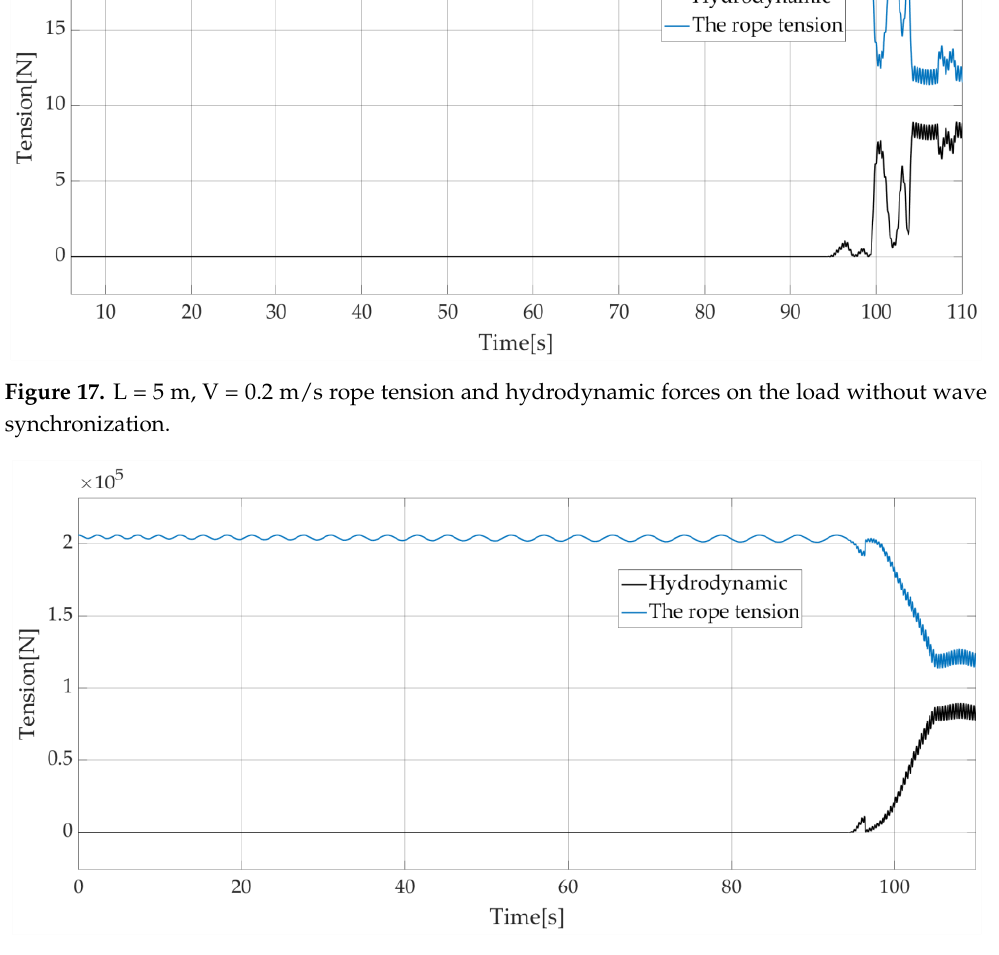
Table 6. Compensation efficiency for different algorithms using results of Figure